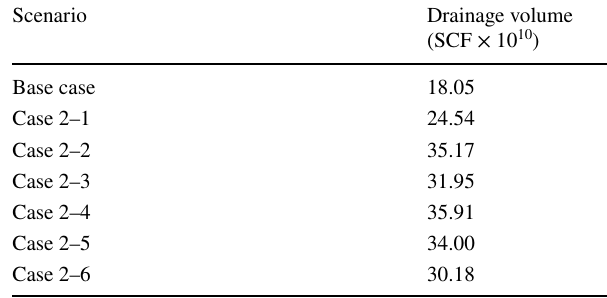
Table 12 C values for all sensitivity scenarios Lateral length (ft)